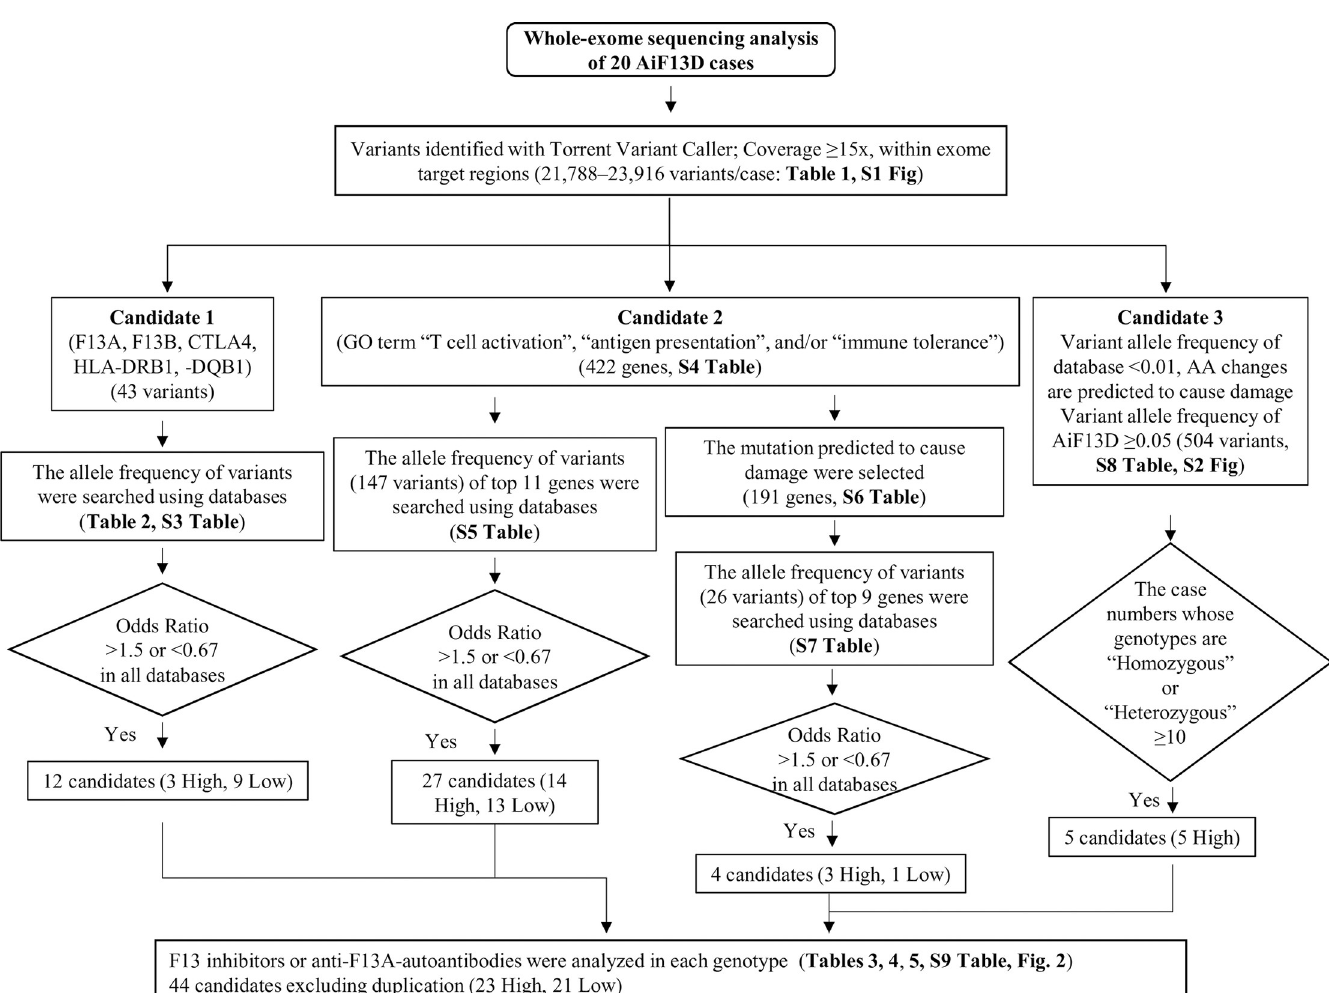
Fig 1. Data analysis and selecting candidate alleles above the criteria from genetic variants identified in whole exome sequencing of 20 autoimmune FXIII deficiency cases. The analytical dataset was obtained by merging all the annotated variants called in the 20 autoimmune FXIII deficiency cases into a single dataset. The candidate alleles were subsequently narrowed down by three selection